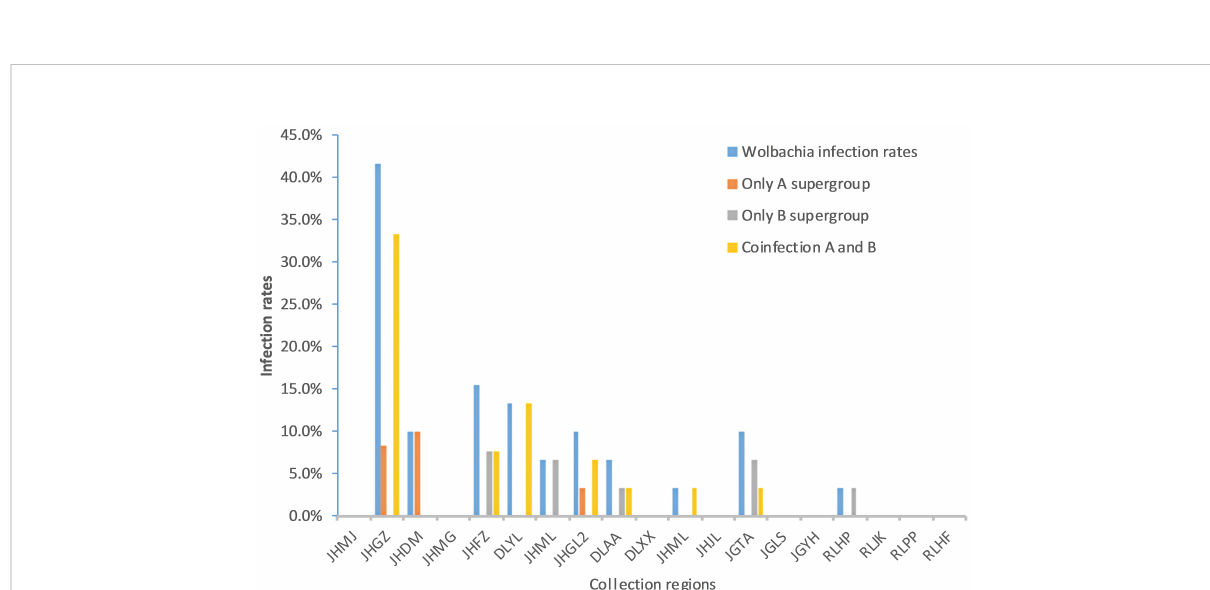
FIGURE 1 Comparison of Wolbachia infection rates among different collection regions in Yunnan Province. JHMJ 、 JHGZ 、 JHDM 、 JHMG 、 JHFZ 、 DLYL 、 JHML 、 JHGL2 、 DLAA 、 DLXX 、 JHML and JHJL belong to Xishuangbanna prefecture, Yunnan. JGTA 、 JGLS 、 JGYH 、 RLHP 、 RLJK 、 RLPP and RLHF belong to Dehong prefecture,